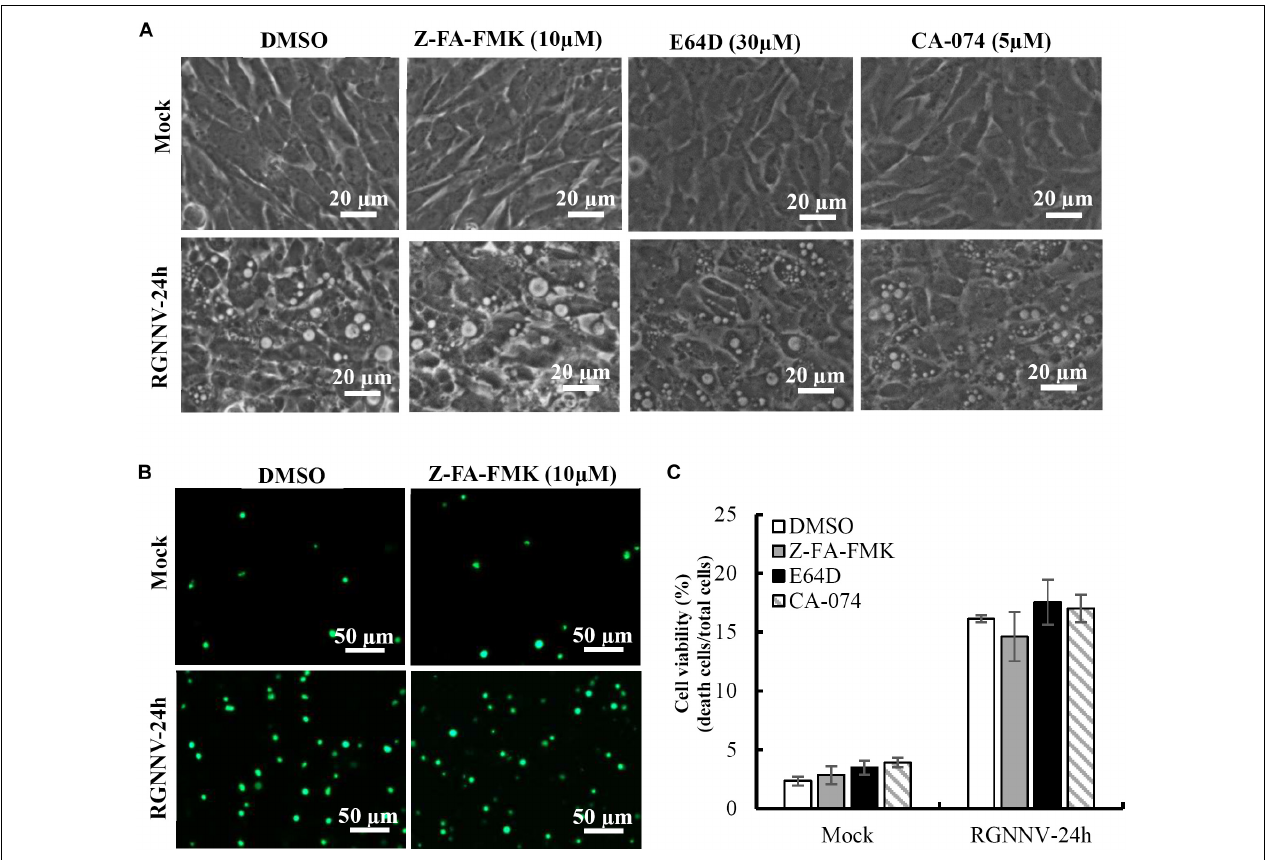
FIGURE 4 | The effects of cathepsin inhibitors on vacuole formation during RGNNV infection. (A) The effects of different inhibitors on RGNNV infection-induced vacuolization. (B) The effect of Z-FA-FMK on cell death induced by RGNNV. (C) The percentage of cell death during RGNNV infection upon treatment with different